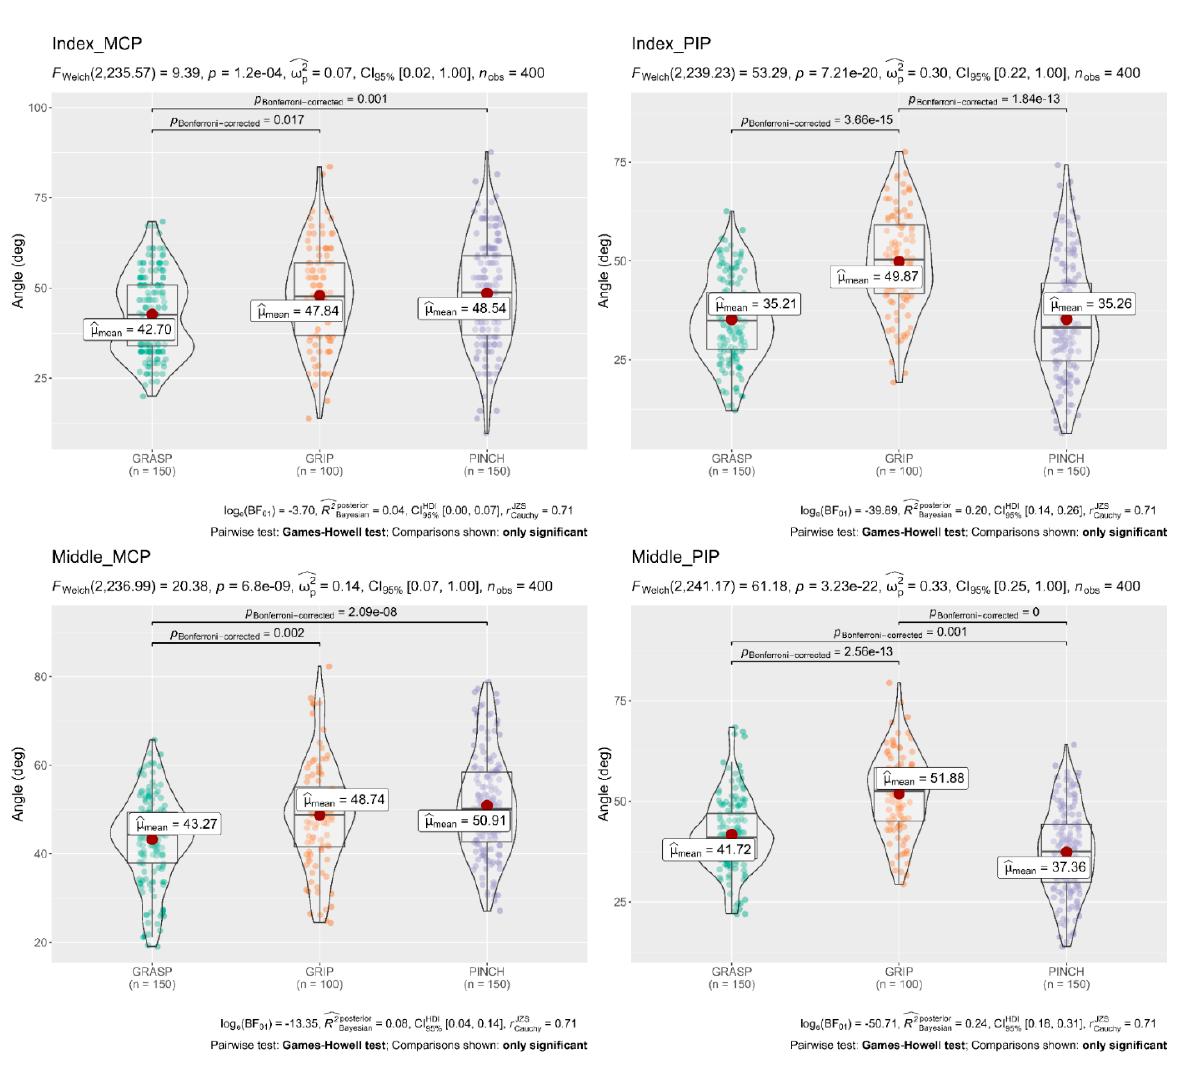
Figure 5. Welch’s ANOVA and post hoc results; Comparison of flexion angles of the Index and Middle joints concerning the three subscales of the ARAT. The flexion angles of the proximal interphalangeal (PIP) joints of the Index and Middle fingers were significantly larger ( p < 0.05 each) in the grip subscale than in the grasp and pinch subscale. In contrast, the flexion angles of the metacarpophalangeal (MCP) joints were significantly larger ( p < 0.05 each) in the pinch subscale than in the grasp subscale. Horizontal lines indicate significant differences ( p < 0.05, Games–Howell test post hoc comparison); deg = degrees.